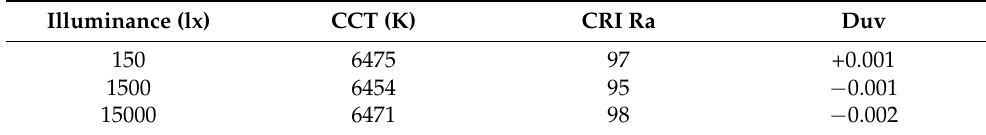
Table 1. Colorimetric characteristics of the light